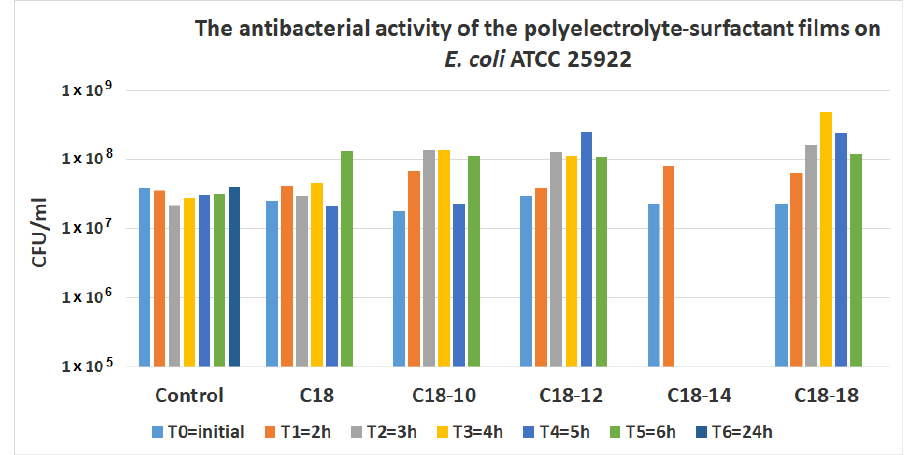
Figure 1. The antibacterial activity of the polyelectrolyte – surfactant films on Escherichia coli ATCC 25922 after different times of contact (initial, 2, 3, 4, 5, 6, and 24 h): (control — clear glass, C18-(PAC 18 Na